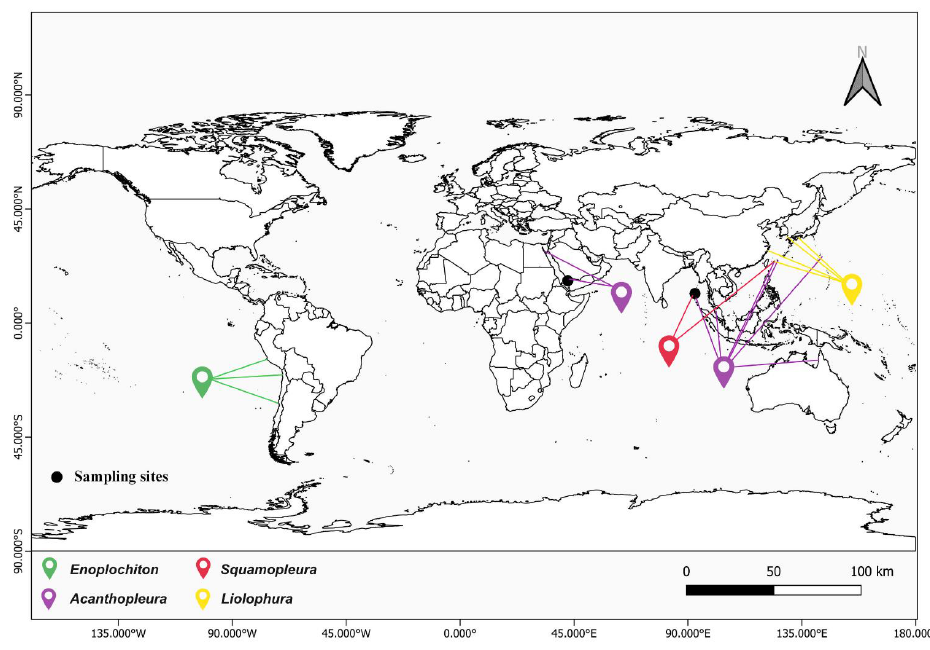
Figure 2. Map showing the sampling locations and the geographical distribution of species from four genera used in the present analysis.